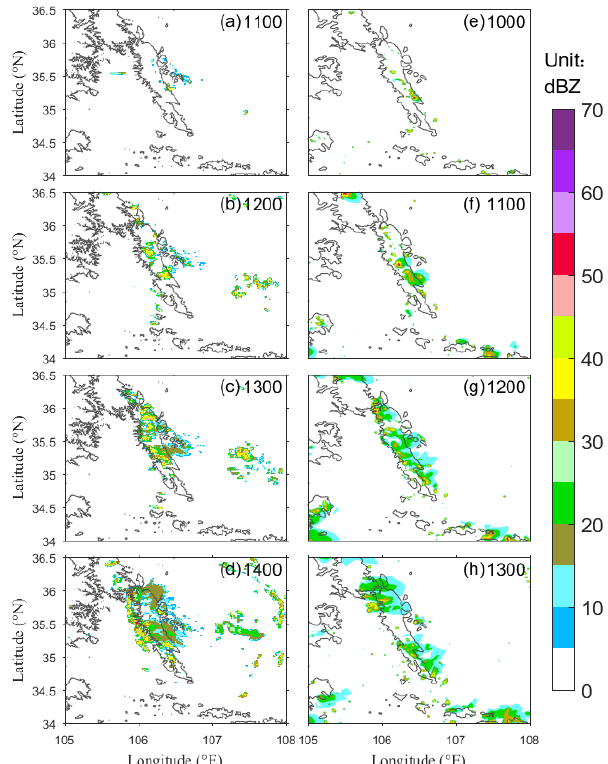
Figure 3. Observed ( a – d ) and simulated ( e – h ) radar composite reflectivity (shaded, units: dBZ), ( a ) 1100, ( b ) 1200, ( c ) 1300, ( d ) 1400; ( e ) 1000, ( f ) 1100, ( g ) 1200, and ( h ) 1300 LST. The solid black lines are the 2000 m terrain contours.